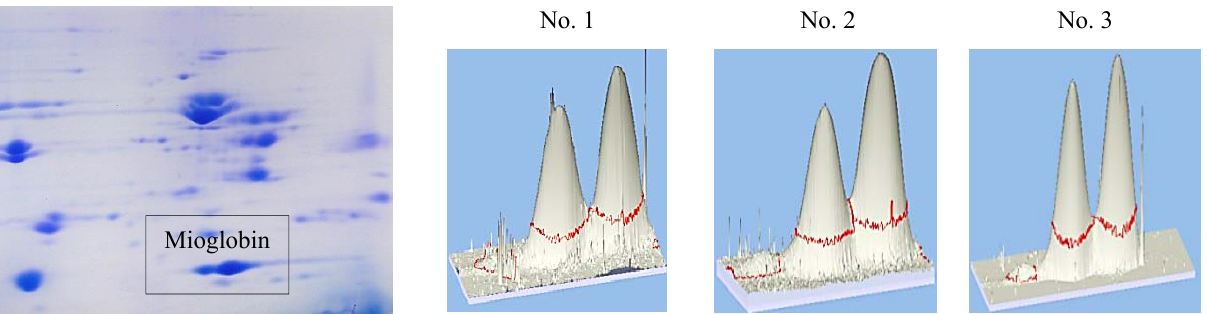
Fig. 6. Ratio of potential myoglobin bio-marker in the study samples (sample No. 3 contains pork and beef in a volume ratio of 60 :